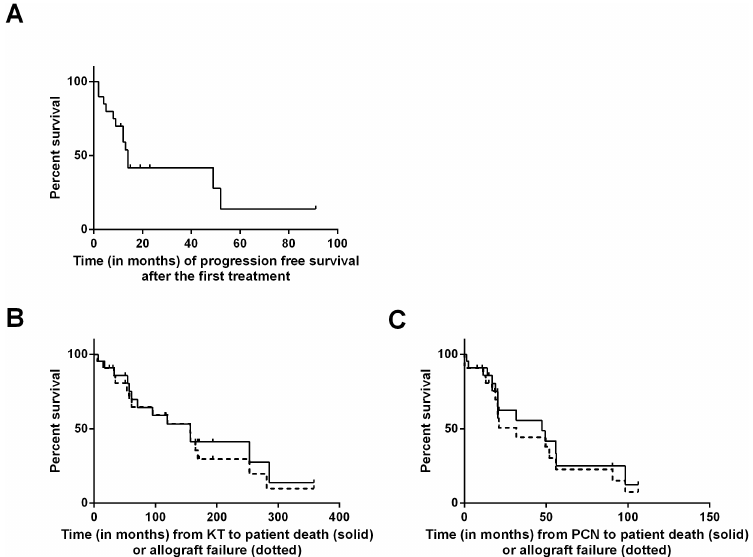
Fig 3. Graft and patient survival. A: Progressionfree survival (in months) after the first treatment for PCN. Medianprogressionfree survival (20/22 patients) was 14 months. B: Survival(in months) from kidney transplantation (KT) of patients (solid) and grafts (dotted). Mediangraft survival after KT was 156.9 and medianpatient survival after KT was 156.9 months. C: Survival(in months) from the time of diagnosisof PCN of patients (solid) and grafts (dotted). Median graft and patient survival after diagnosis of PCN was 31.7 months and 49.4 months, respectively.PCN: plasma cell neoplasia.